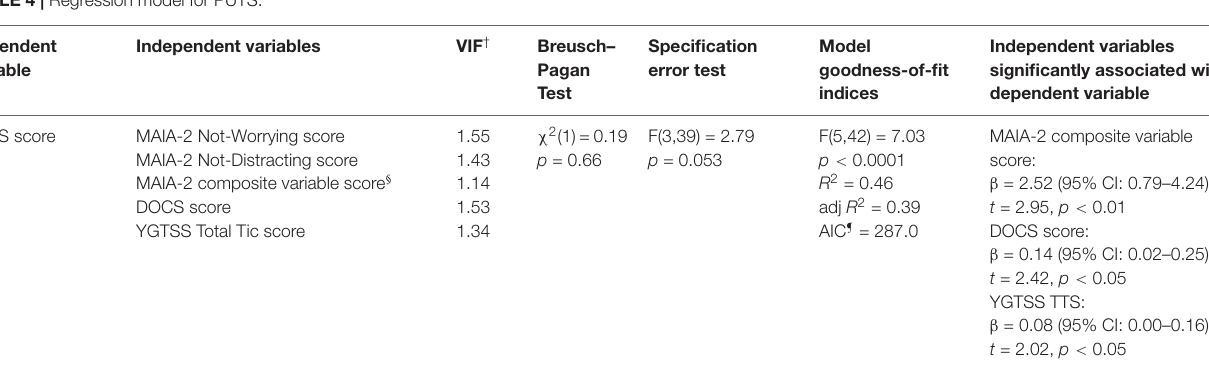
FIGURE 1 | Bivariate correlation matrix for CTD participants. Intensity of shading reflects magnitude of Spearman rank correlation, with blue indicating positive correlation and red indicating negative correlation. Correlations with absolute values ≥ 0.34 are significant, as per the false discovery rate-controlling procedure. TTS, Total Tic Score. TABLE 4 | Regression model for